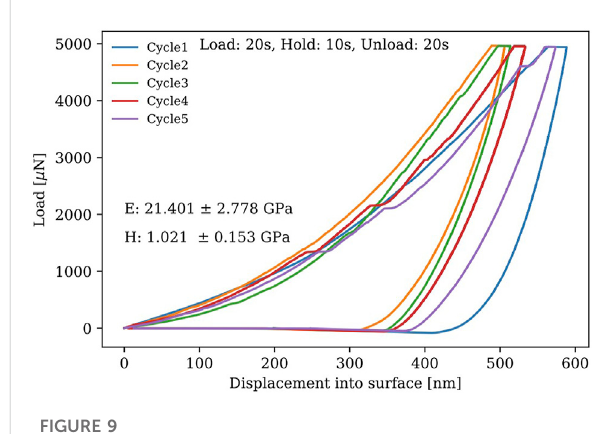
FIGURE 7 Current-voltage (I – V) curve was measured on a Ag/Cs 3 Bi 2 Br 9 /Ag device at room temperature.